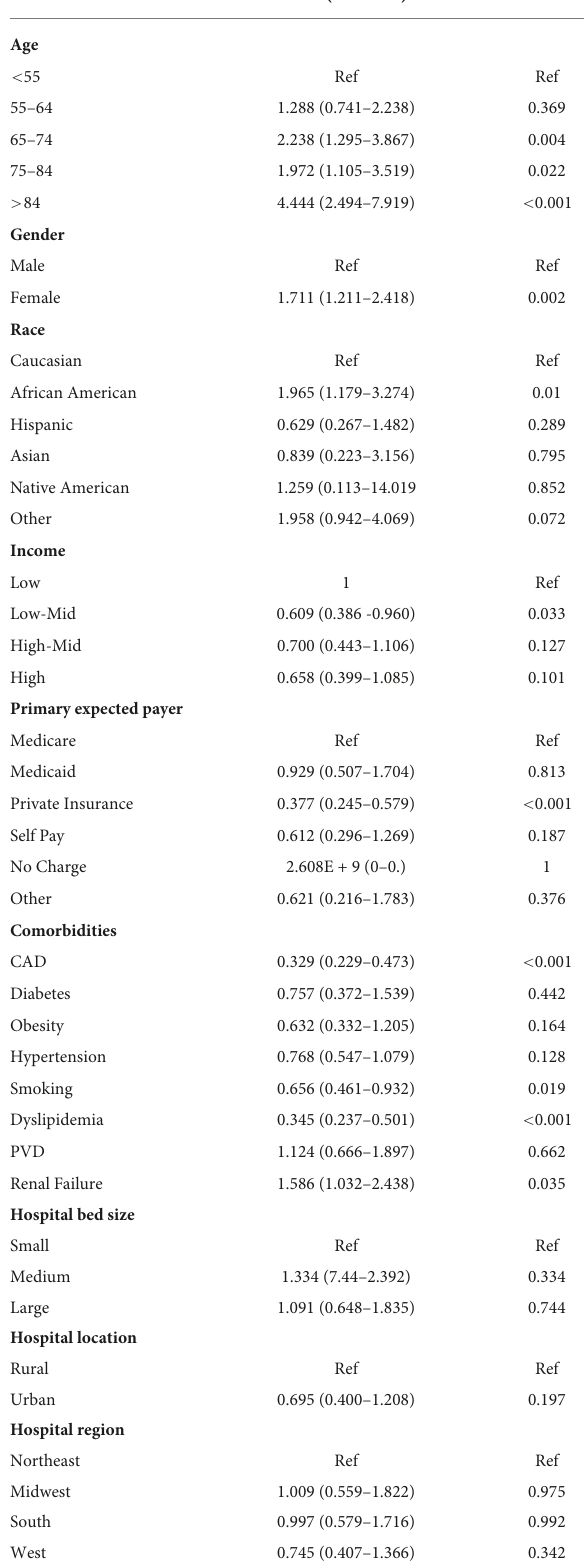
TABLE 4 Predictors of mortality in STEMI patients with